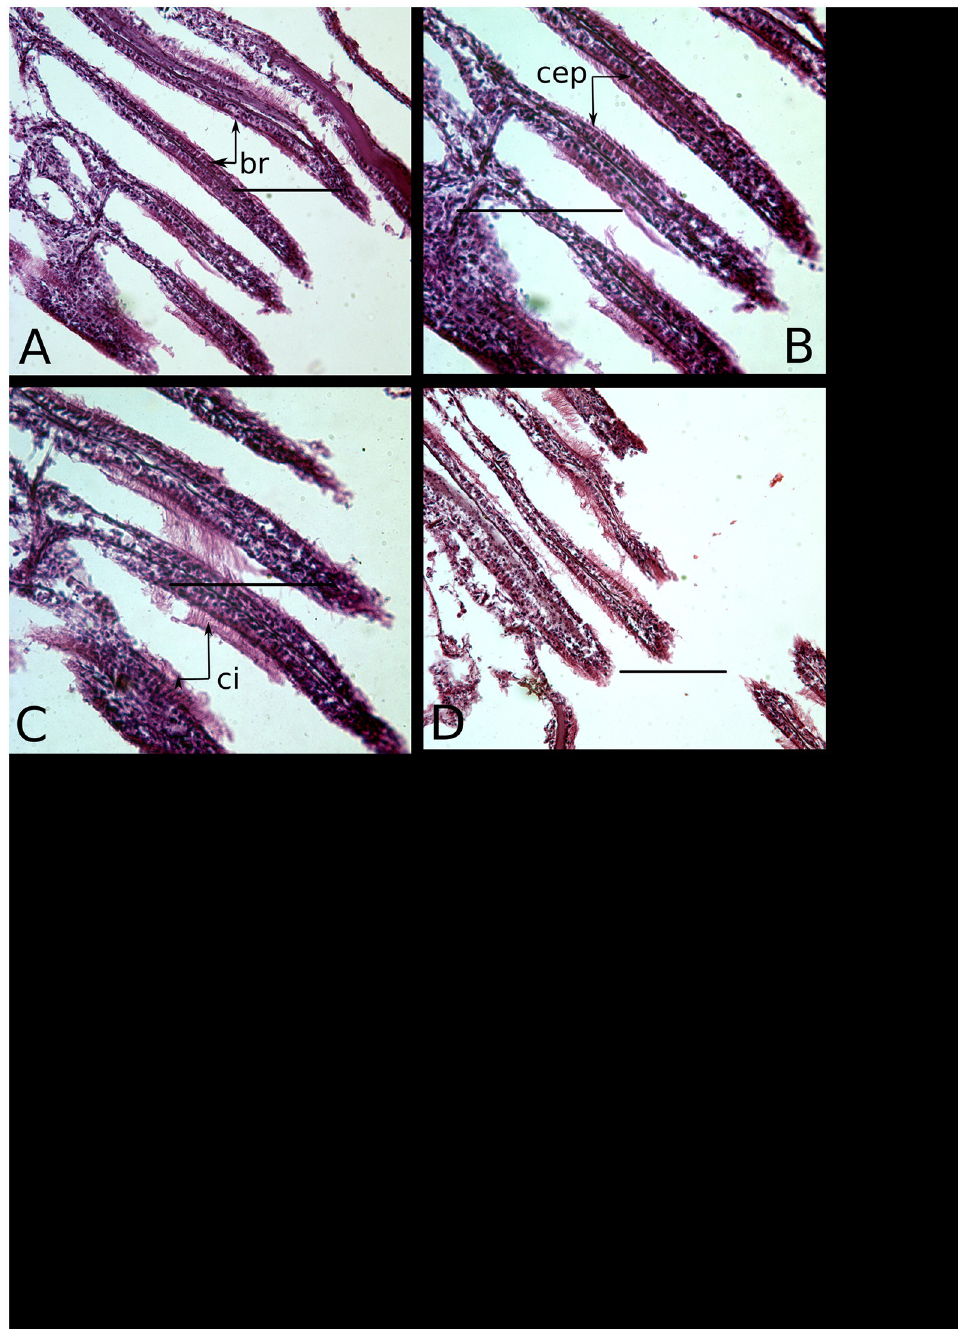
Fig 1. Normal ctenidial branches of C. virginica individuals from Chesapeake Bay. Three individuals are represented, the first in photographs A and B, and then C and D respectively. Labels: br—ctenidial branch; ci—cilia; cep—columnar epithelia. All scale bars are 100 μ